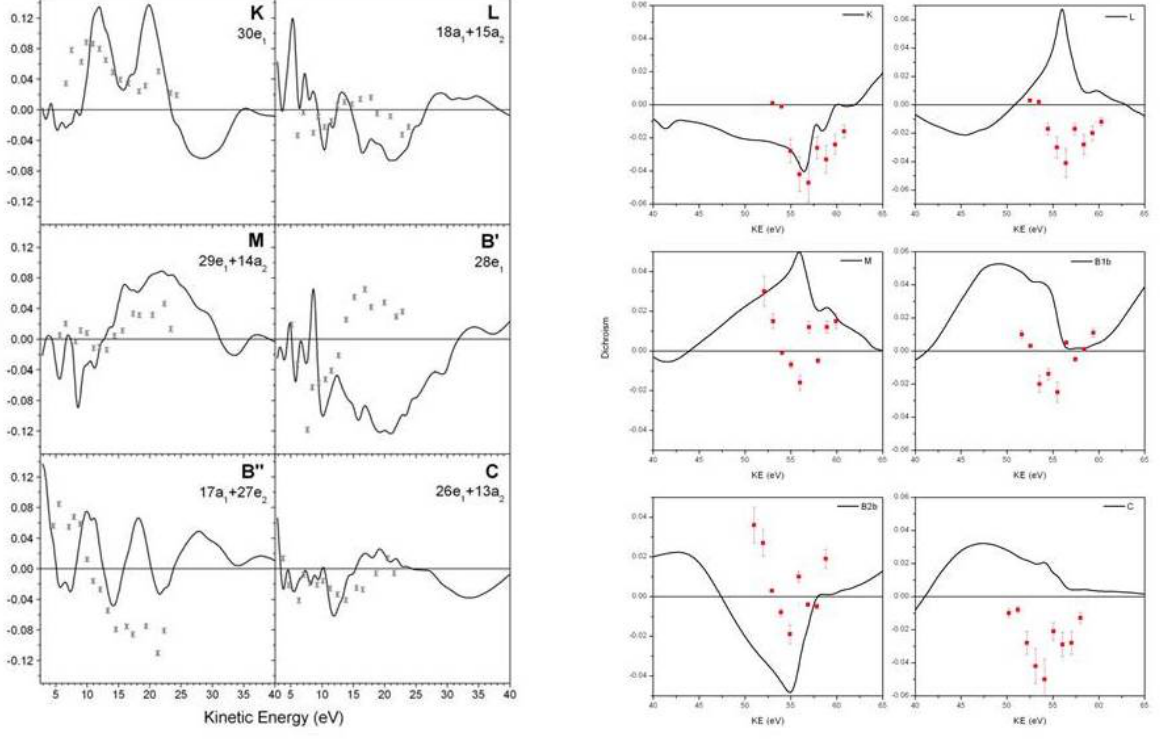
Figure 6. β 1 parameter computed for the valence levels of Cobalt tris-acetylacetonate (from [51] with permission). Right panel in the region of autoionization